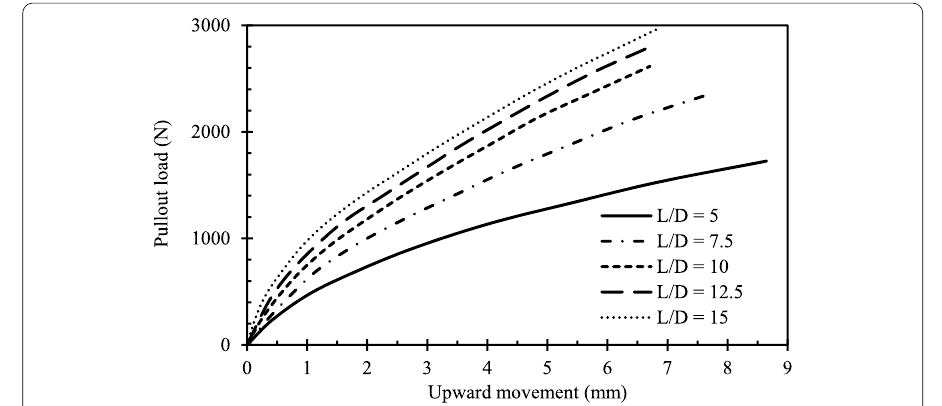
Fig. 5 Pullout behaviour of 50 mm diameter GPA